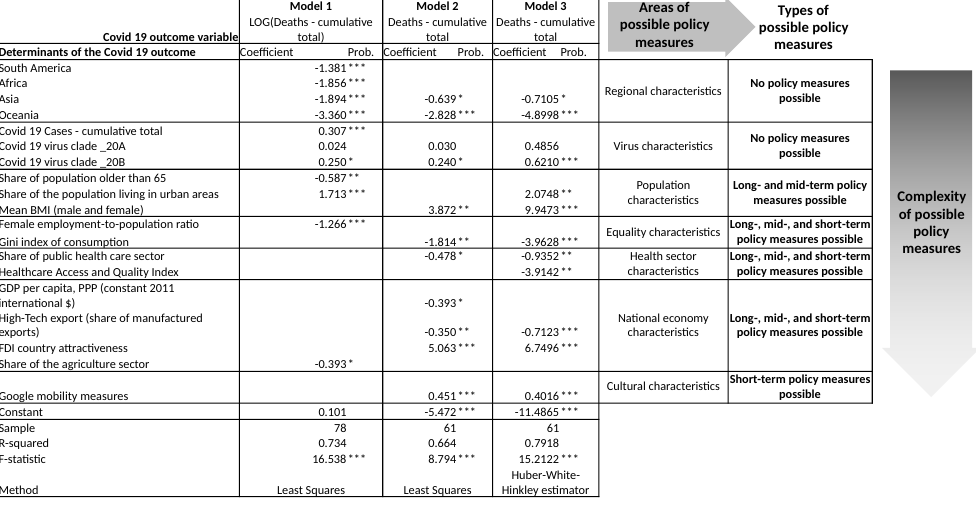
Figure 1. ‘*’ = p -value lower than 0.10, ‘**’ = p -value lower than 0.05, ‘***’ = p -value lower than 0.01. Economic policy framework for determining pandemic outbreak measures. Source: own calculations and figure